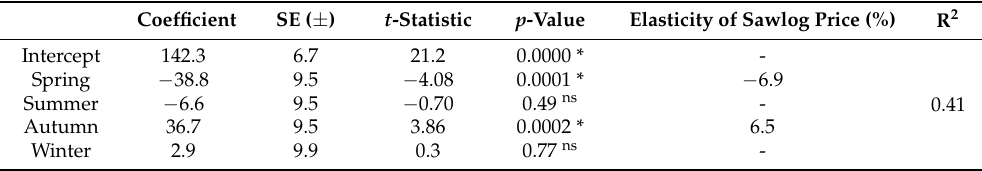
Table 3. Parameter estimation of seasonal price for high-value species lumber (model 2). Coefficient SE ( ± ) t -Statistic p -Value Elasticity of Lumber Price (%) R 2 Intercept 72.0 4.1 Spring − 10.5